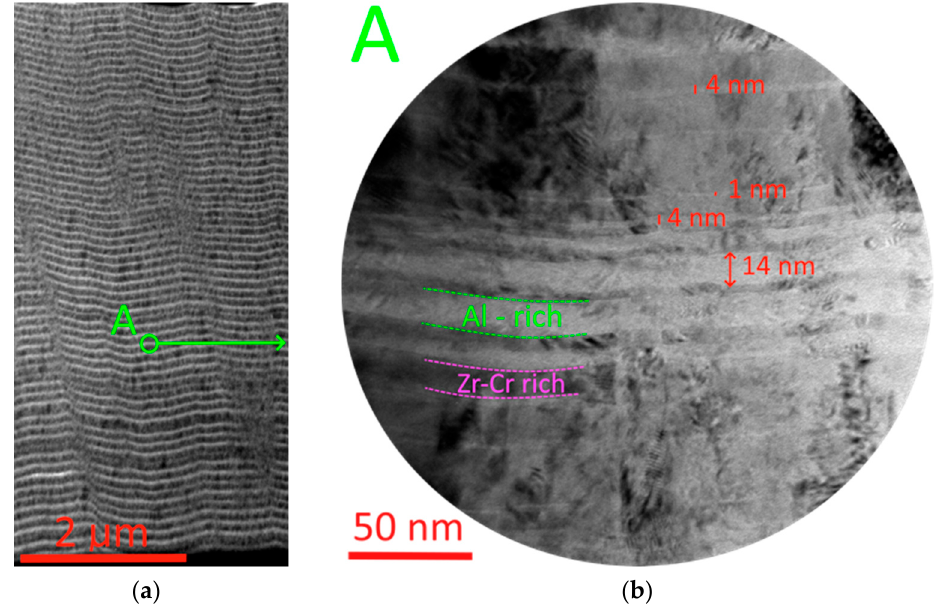
Figure 8. An example of a multilayer structure of a (Zr,Cr,Al)N coating that has a nanolayer structure with alternating nanolayers dominated by Zr–Cr or Al (TEM). ( a ) General coating structure; ( b ) nanolayer